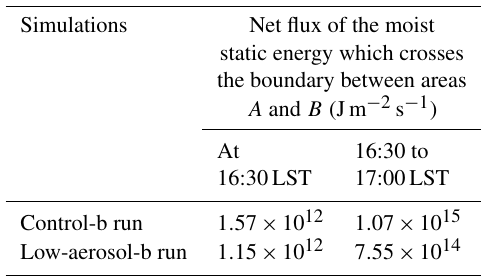
Table 2. The net flux of the moist static energy which crosses the boundary between areas A and B at 16:30LST and for a period from 16:30 to 17:00LST.